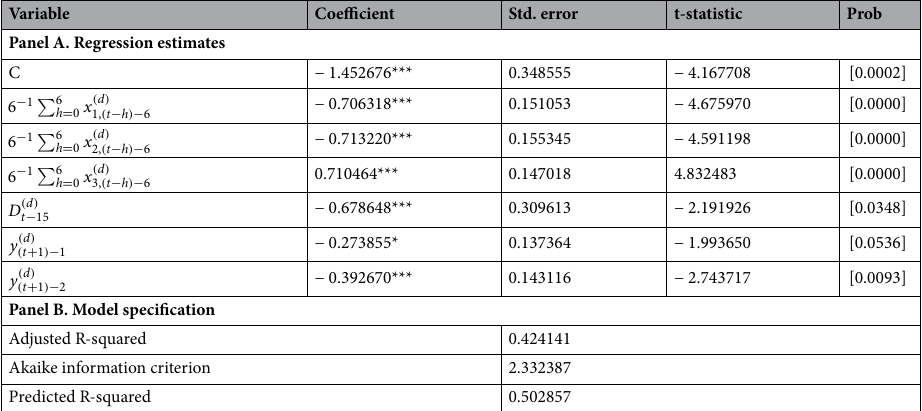
Table 7. Heterogeneous autoregressive model with explanatory variables AR ( 2 ) − H X for daily deaths. ***, **, and * denote statistical significance at 1%, 5%, and 10%, respectively. Bootstrapped coefficient estimates and standard errors via 2000 repetitions. The final optimal number of days (w) and ( ´ w ) are selected according to the Akaike information criterion. The variance inflation factor (VIF) is used in order to deal with multicollinearity issues among the regressors. Regressors with values of VIF higher than 5 are excluded from the estimation analysis. The variable is divided by its full-sample standard deviation, estimated based on the basic formula of the variable’s standard deviation. Therefore, the inherent variability of each variable is moved, and all variables have a standard deviation of